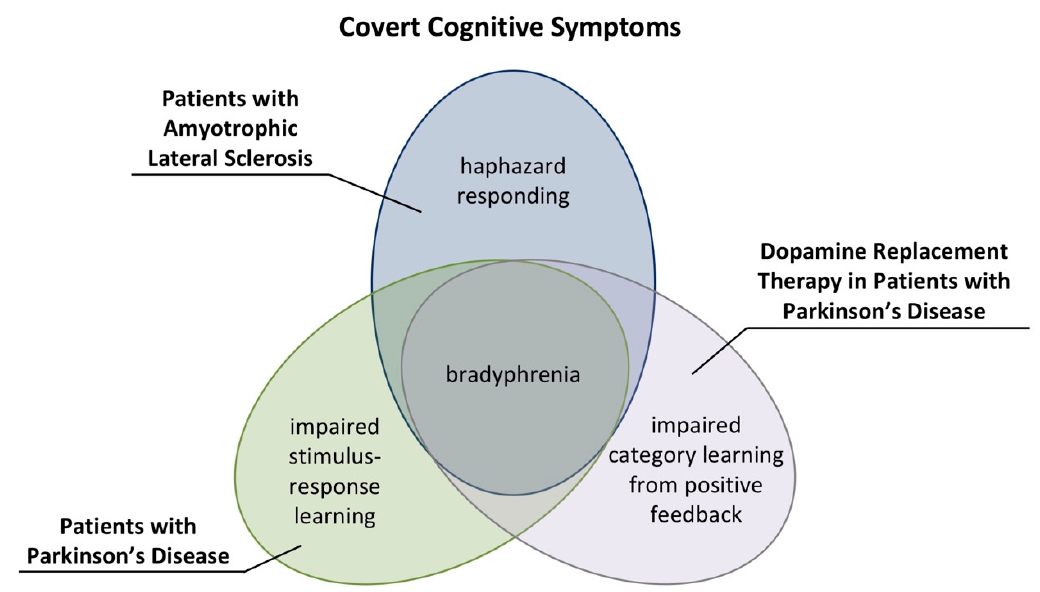
Figure 8. Profiles of covert cognitive symptoms in patients with PD and patients with ALS [109,115].